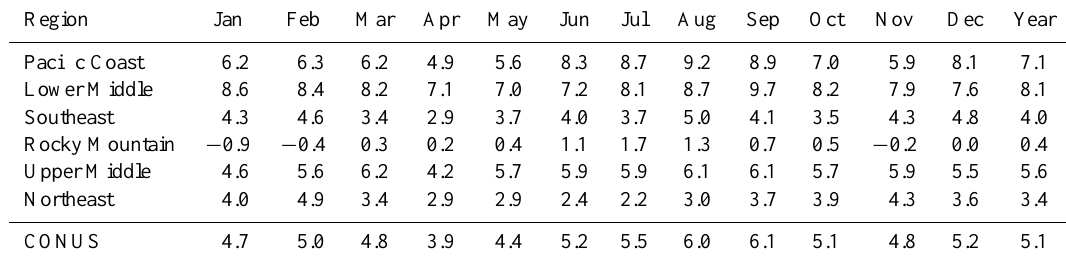
Table 3. Monthly and annual averaged NO 2 biases in different regions and CONUS in 2010. Unit: ppbv. Region Jan